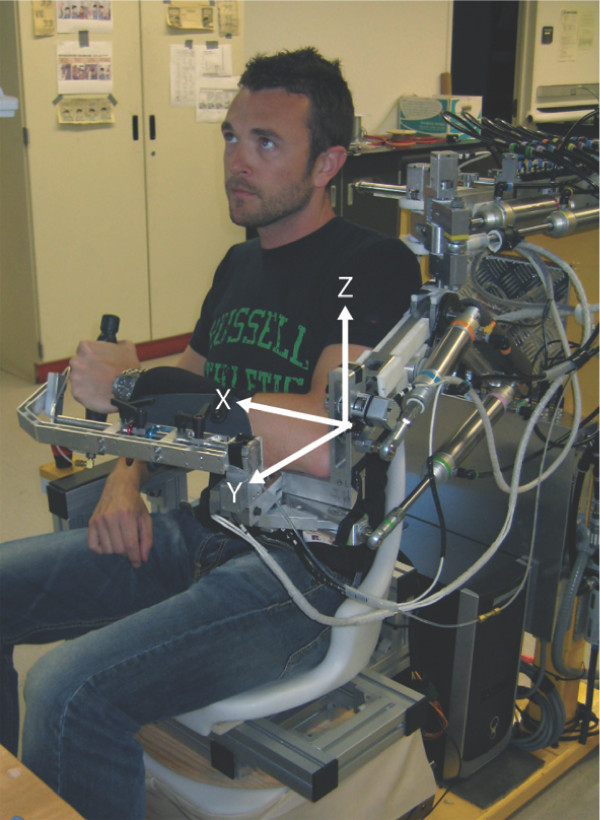
Pneu-WREX. Pneumatic exoskeleton [28] used to perform clinical trials.